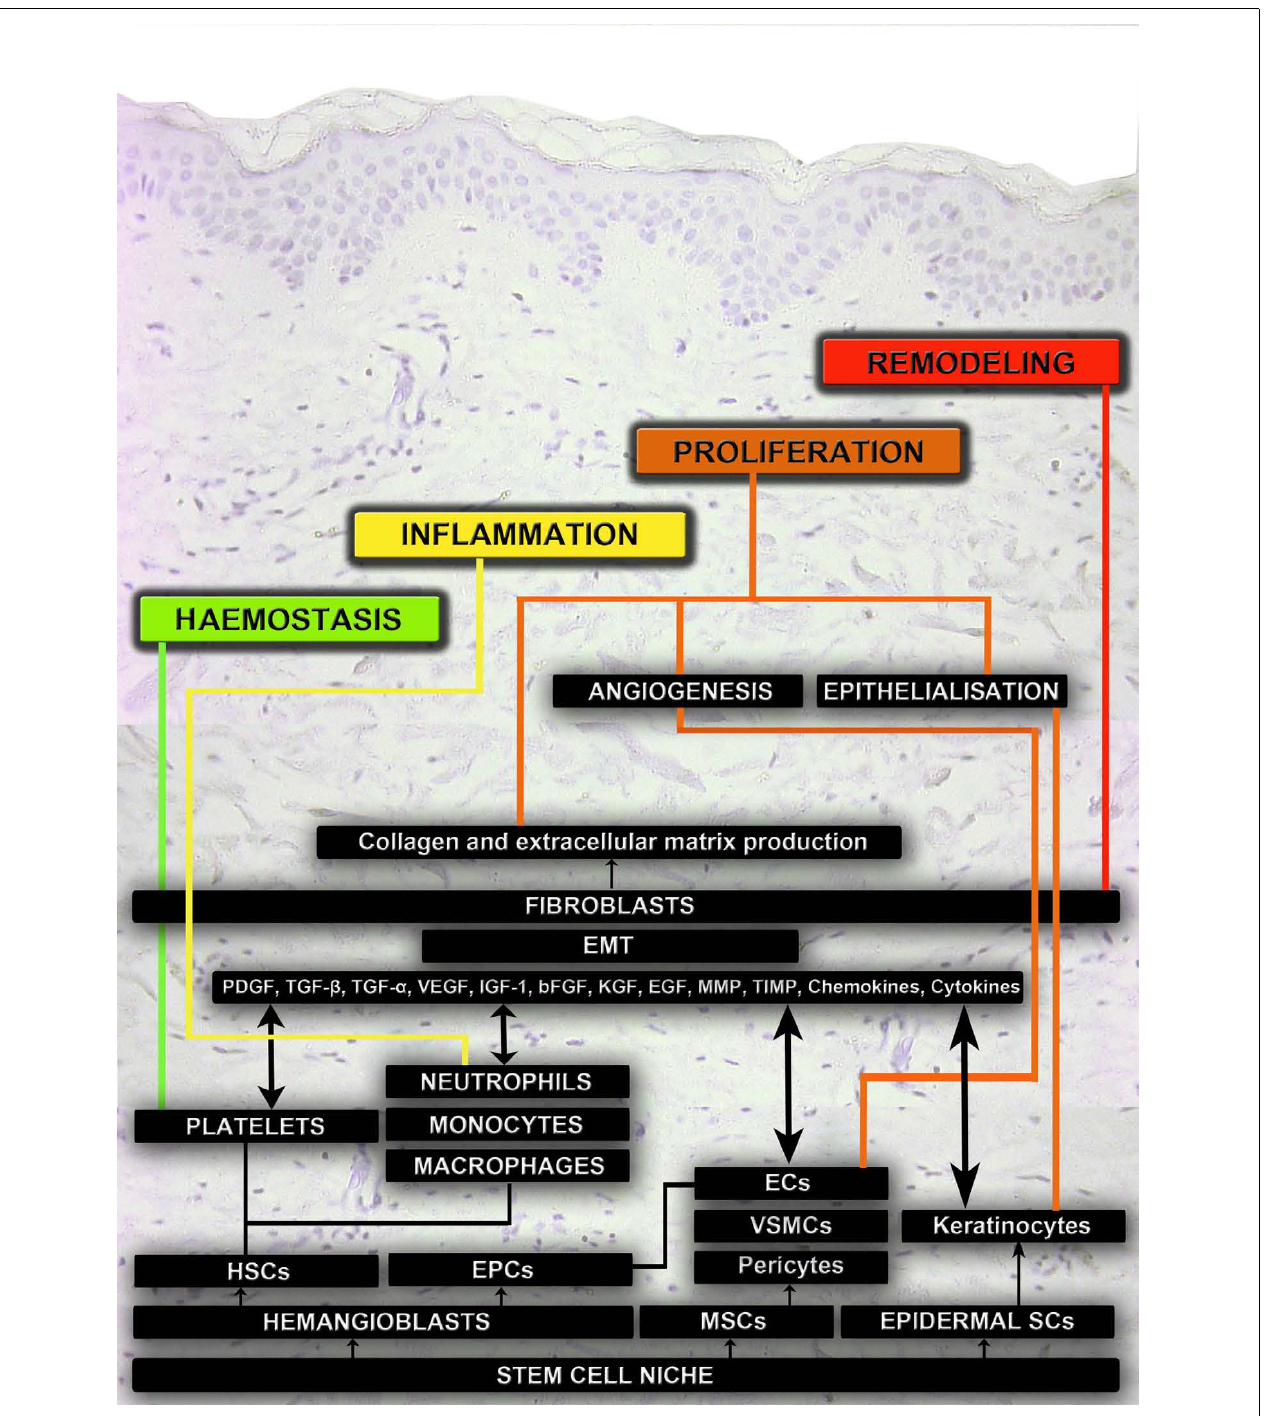
Mesenchymal stem cells (MSCs), endothelial progenitor cells (EPCs), pericytes, vascular smooth muscle cells (VSMCs), endothelial cells (ECs), and fibroblasts regulate angiogenesis. Epithelial mesenchymal transitions (EMT), fibroblasts and fibrocytes regulate collagen, and extracellular matrix (ECM) production. Epidermal stem cells (ESCs) and keratinocytes regulate epithelialization. Fibroblasts and proteolytic enzymes regulate remodeling in the final phase of wound